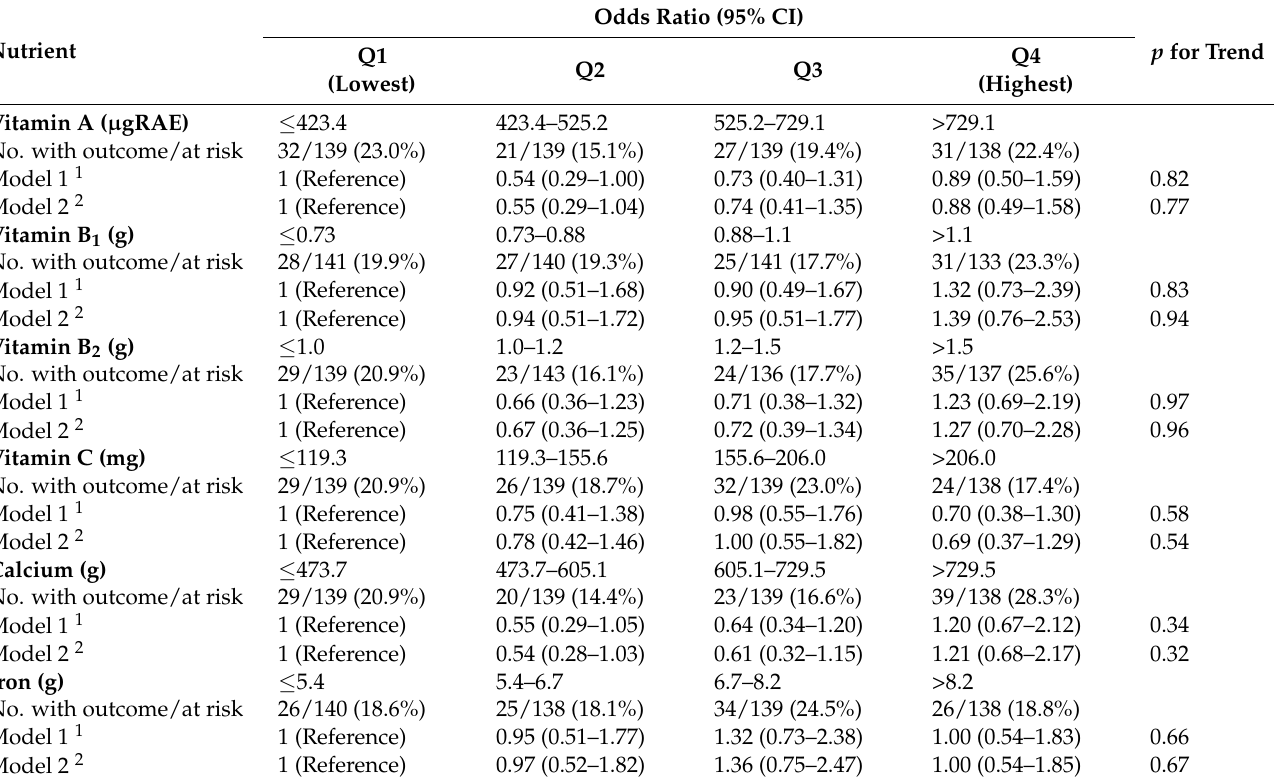
Table 4. Associations between energy-adjusted micronutrient intake and early AMD in multivariate logistic regression